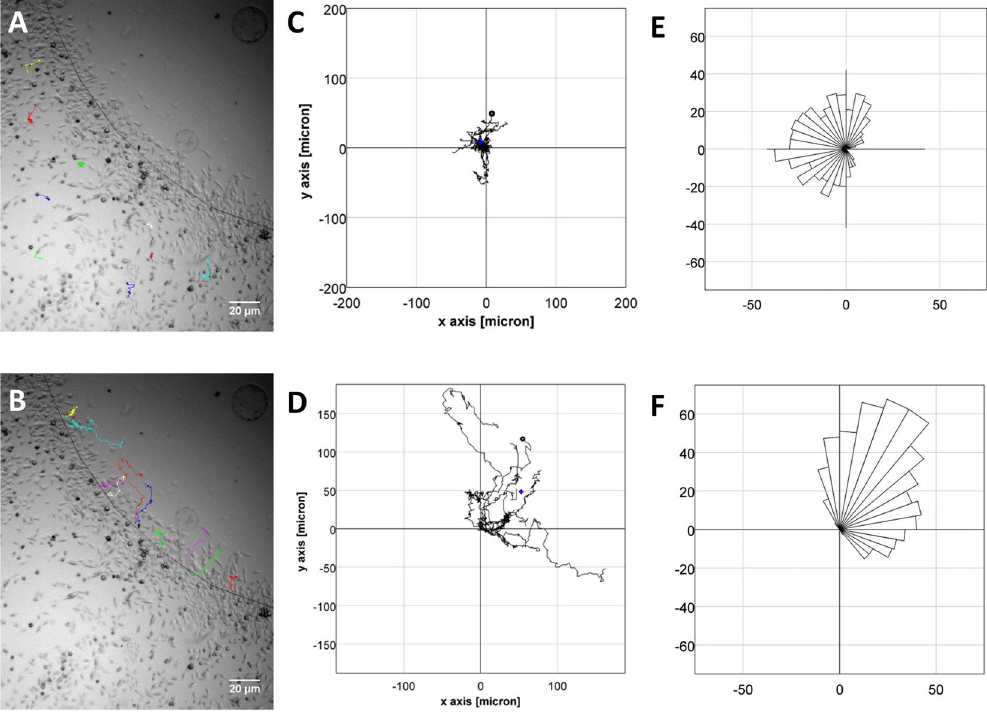
Figure 4. ( A ) Tracks of ten randomly selected PC-3 cells away from the agarose spot containing CCL21. ( B ) Tracks of ten randomly selected PC-3 cells from the edge of the agarose spot containing CCL21. ( C ) Plots of overlapped tracks for PC-3 cells away from the agarose. Center of mass is ( − 3.4 µ m, 13 µ m), mean of accumulated distance travelled is 218 ± 82 µ m, average velocity is 0.13 µ m/min. ( D ) Plots of overlapped tracks for PC-3 cells from the edge of the agarose. Center of mass is (53 µ m, 48 µ m), mean of accumulated distance travelled is 320 ± 84 µ m, average velocity is 0.30 µ m/min. ( E ) Rose diagram showing lack of directionality in PC-3 cells away from the agarose spot. ( F ) Rose diagram showing directionality towards the center of the spot in PC-3 cells under the agarose